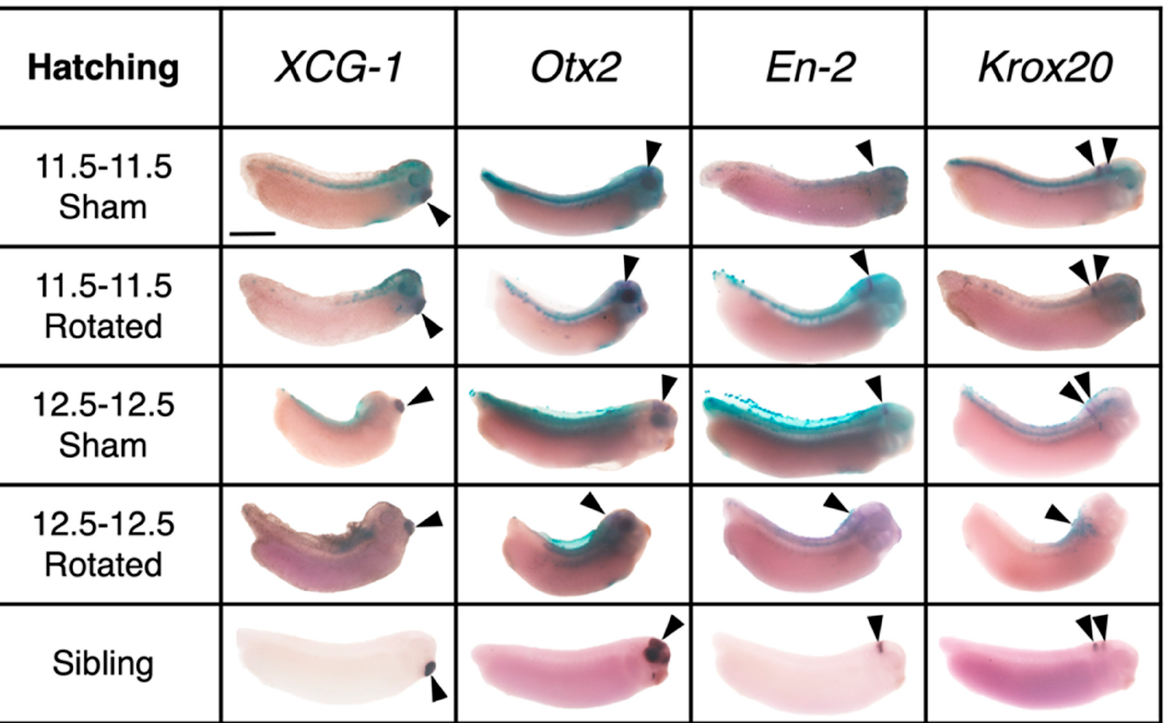
Figure 8. Representative examples of expression of regional marker genes in transplants and sibling controls at hatching stage. Lateral view of all embryos with dorsal facing up; anterior is to the right. Purple stain marked with a solid arrowhead indicates gene expression and blue stain indicates transplant incorporation. Scale bar represents 1 mm.